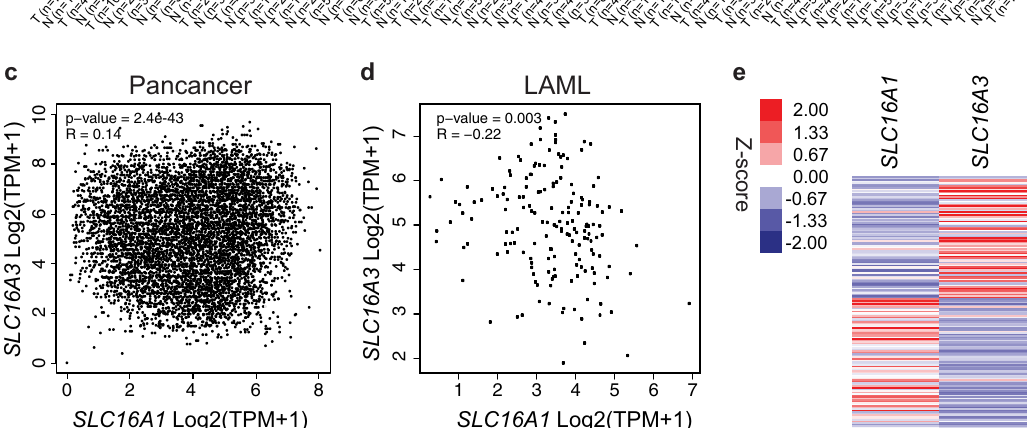
Fig. 7 Gene expression pattern of monocarboxylate transporters in cancer patients. a, b Comparison of SLC16A1 and SLC16A3 expression in cancer patient and normal samples (derived from matching TCGA or Genotype-Tissue Expression (GTEx) project 47 . The analysis was performed with the gene expression pro fi ling interactive analysis (GEPIA2) server 46 utilizing RNA-Seq datasets based on the UCSC Xena project 45 (http://xena.ucsc.edu), which are computed by a standard pipeline. Disease entities highlighted in red indicate signi fi cantly higher expression in cancer patients, whereas highlighted in green indicate signi fi cantly higher expression in normal samples (log2 fold-change cutoff 1; q cutoff 0.01). The median gene expression is shown. Abbreviations details for the cancer types are available on the GEPIA server website http://gepia.cancer-pku.cn/index.html. LAML indicates